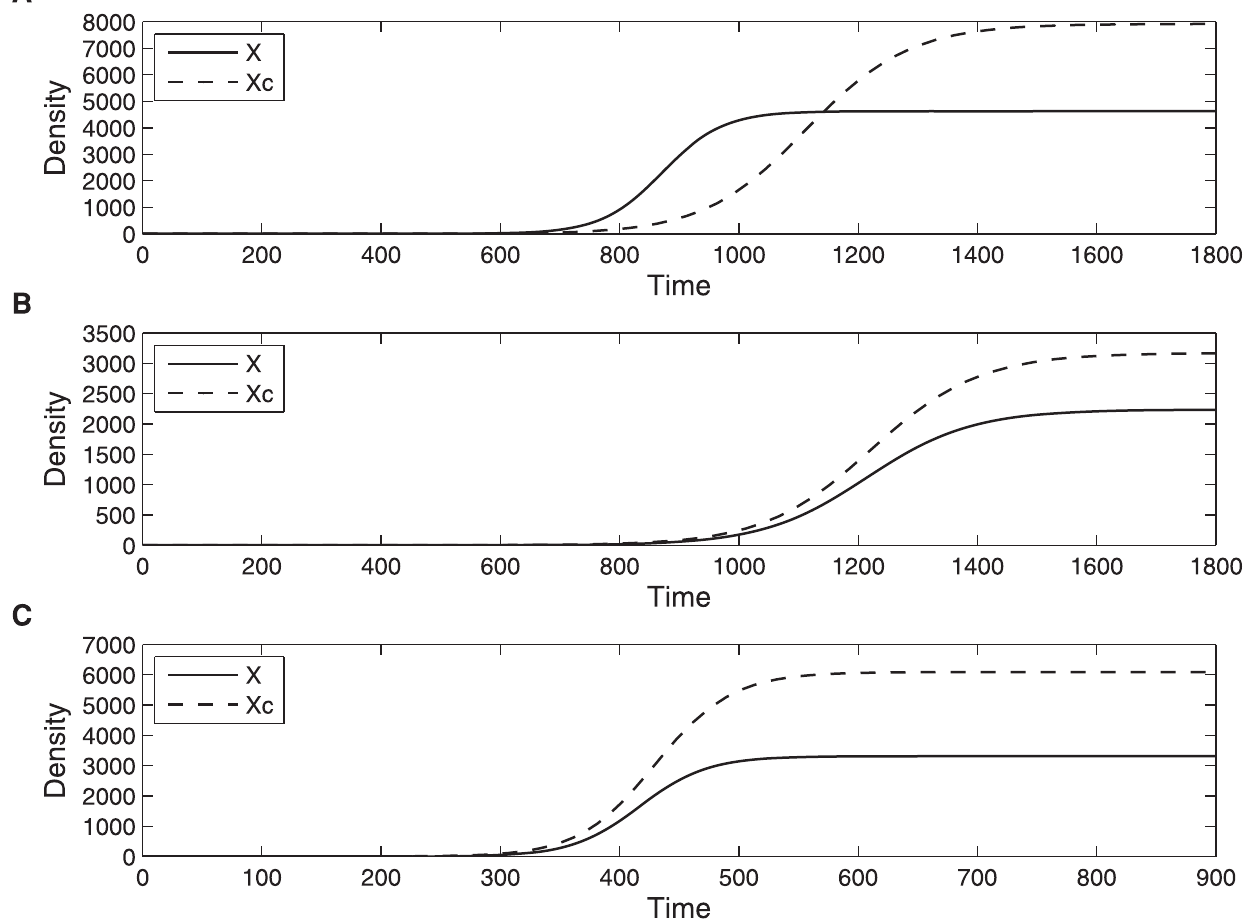
Figure 2. Simulation of two-species population growth for the model (1) and model (2). In the case of model (1) type X and Y cross-feed each other and in the case of model (2) X c doesn’t cross-feed Y but Y cross-feeds X c . Here we plot X ( t ) solution of (1) (full line) together with X c ( t ) =0.009, b xy = b yx =0.01; B . r y =0.011 , r x =0.008, r x solution of (2) (dashed line) with A . r y =0.011, r x =0.008, r x c =0.025, b xy = b yx =0.01. For both simulations of model (1) and (2) and in all three cases presented here K =10000, c y ~ c x ~ c x r x =0.015, r x c e 1 = e 2 =0.01.